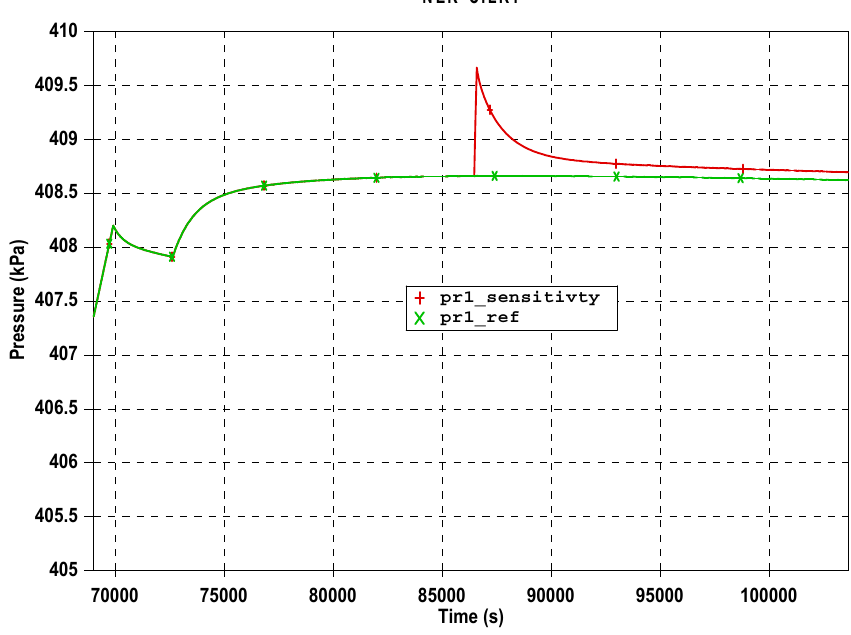
Figure 8. Containment pressure increase due to the addition of a localized heat source.